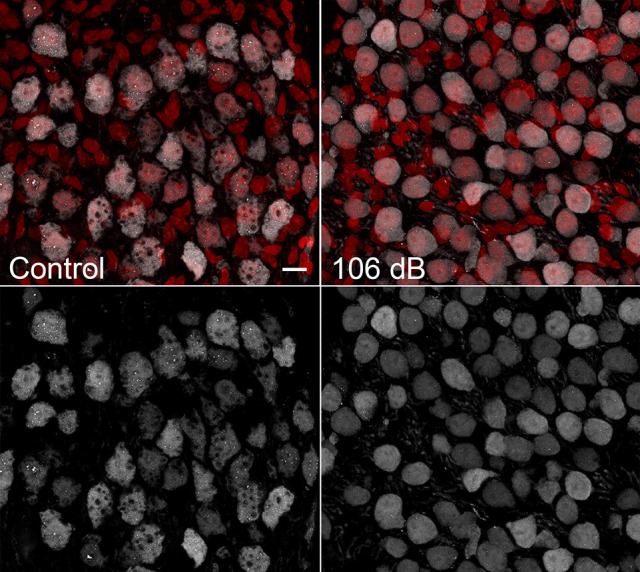
Validation of m/z 11353 protein candidate Parvalbumin alpha. Immunostaining for Parvalbumin alpha in CBA/CaJ cochlear frozen sections detects Parvalbumin alpha in a subset of auditory nerve neuronal cells. One day after noise exposure at 106 dB, Parvalbumin alpha distribution was somewhat altered, with immunoreactivity distributed more uniformly throughout the cytoplasm. Scale bar: 10 μm.